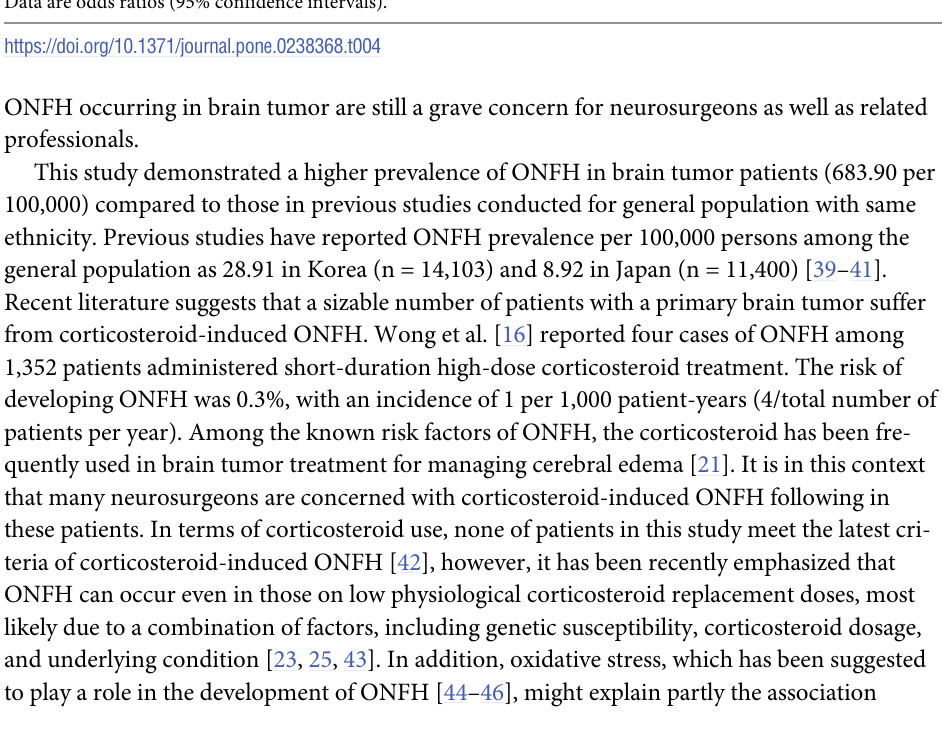
Table 5. Multivariate logistic regression analysis of variables associated with the development of ONFH in brain tumor patients. Odds ratio (95% CI) P -value Chemotherapy 0.451